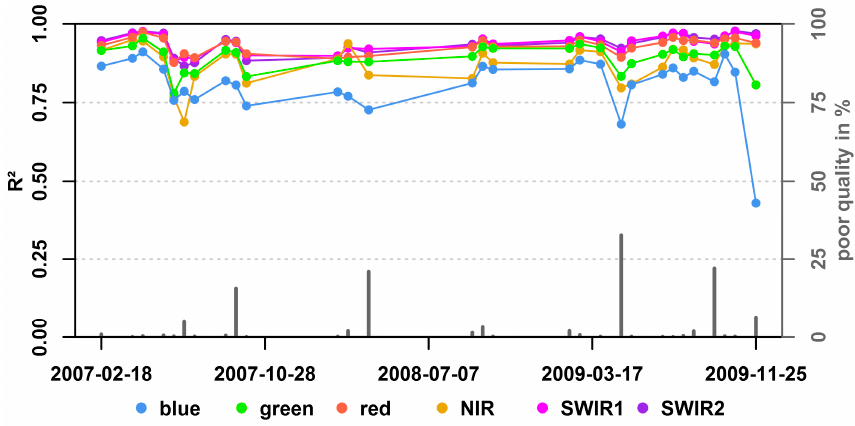
Figure 6. Coefficient of determination R 2 , inferred from linear regressions between observed Landsat images and synthetic equivalent imagery. The Landsat poor quality percentage is shown as vertical bars.